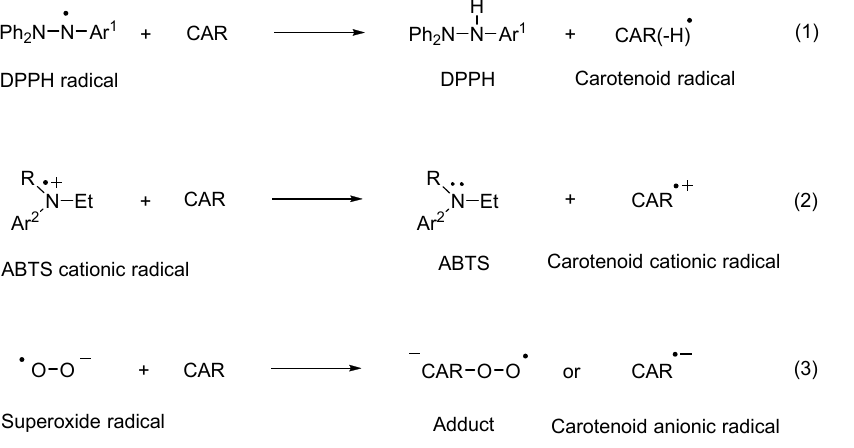
Table S1: Antioxidant activity by DPPH, ABTS, and superoxide radical scavenging assays, 1 H- and 13 C-NMR spectra, Assignment of E -stereochemistry for 4 by N.O.E., and Peak assignment for 2b by COSY, HMBC, and